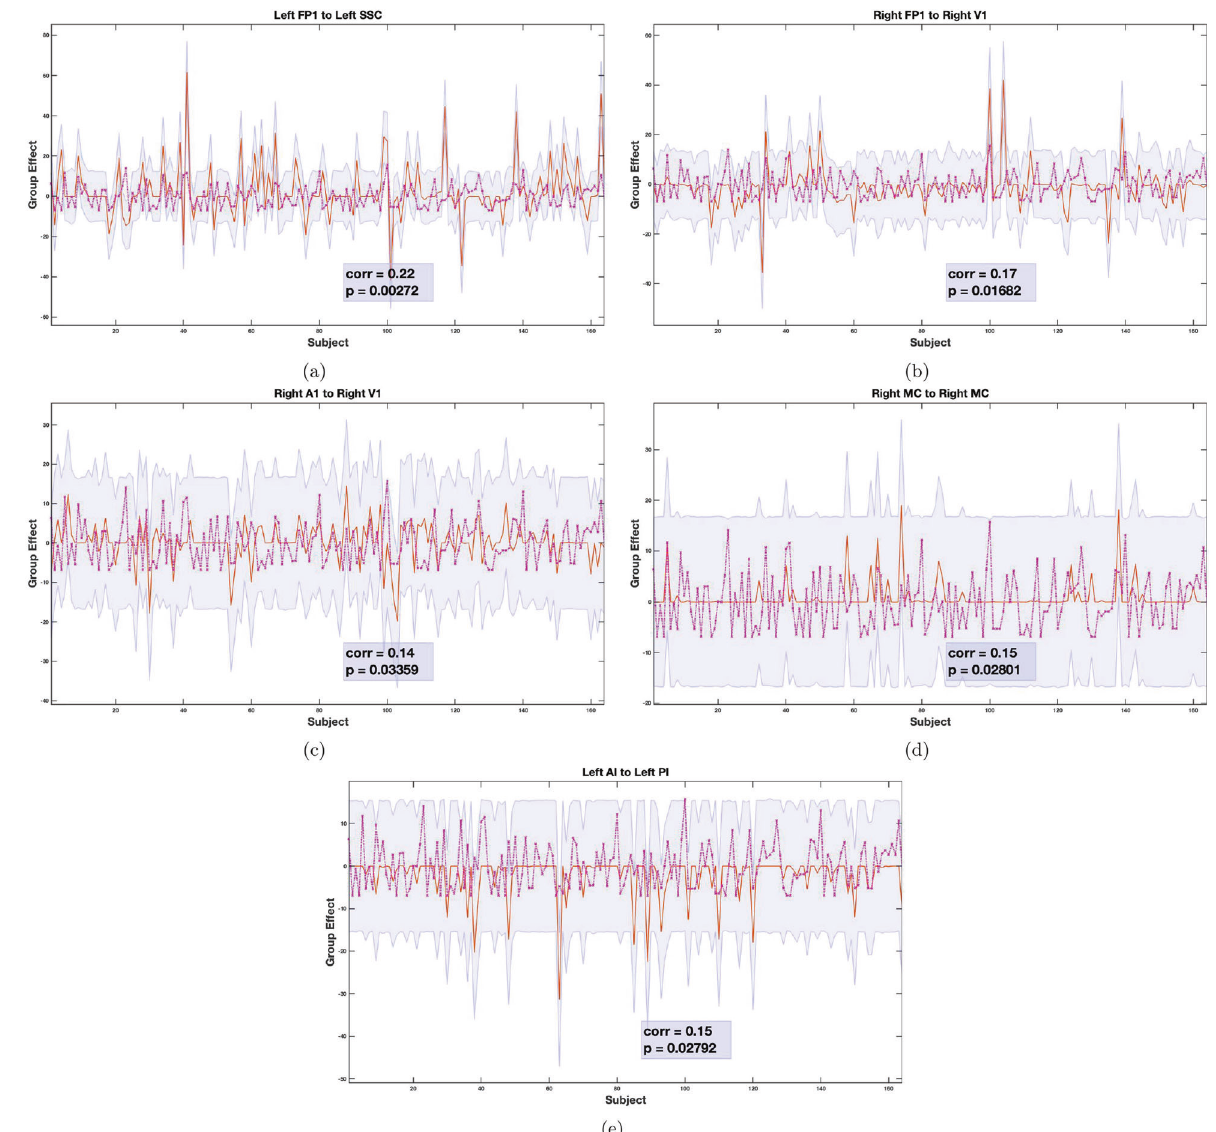
Fig. 6 Leave one out cross validation analysis. The out-of-samples estimate of FSA score for each subject (orange line) with 90% con fi dence interval (shaded area). The purple line represents the actual FSA score. Correlation values between actual and estimated FSA scores are shown in the